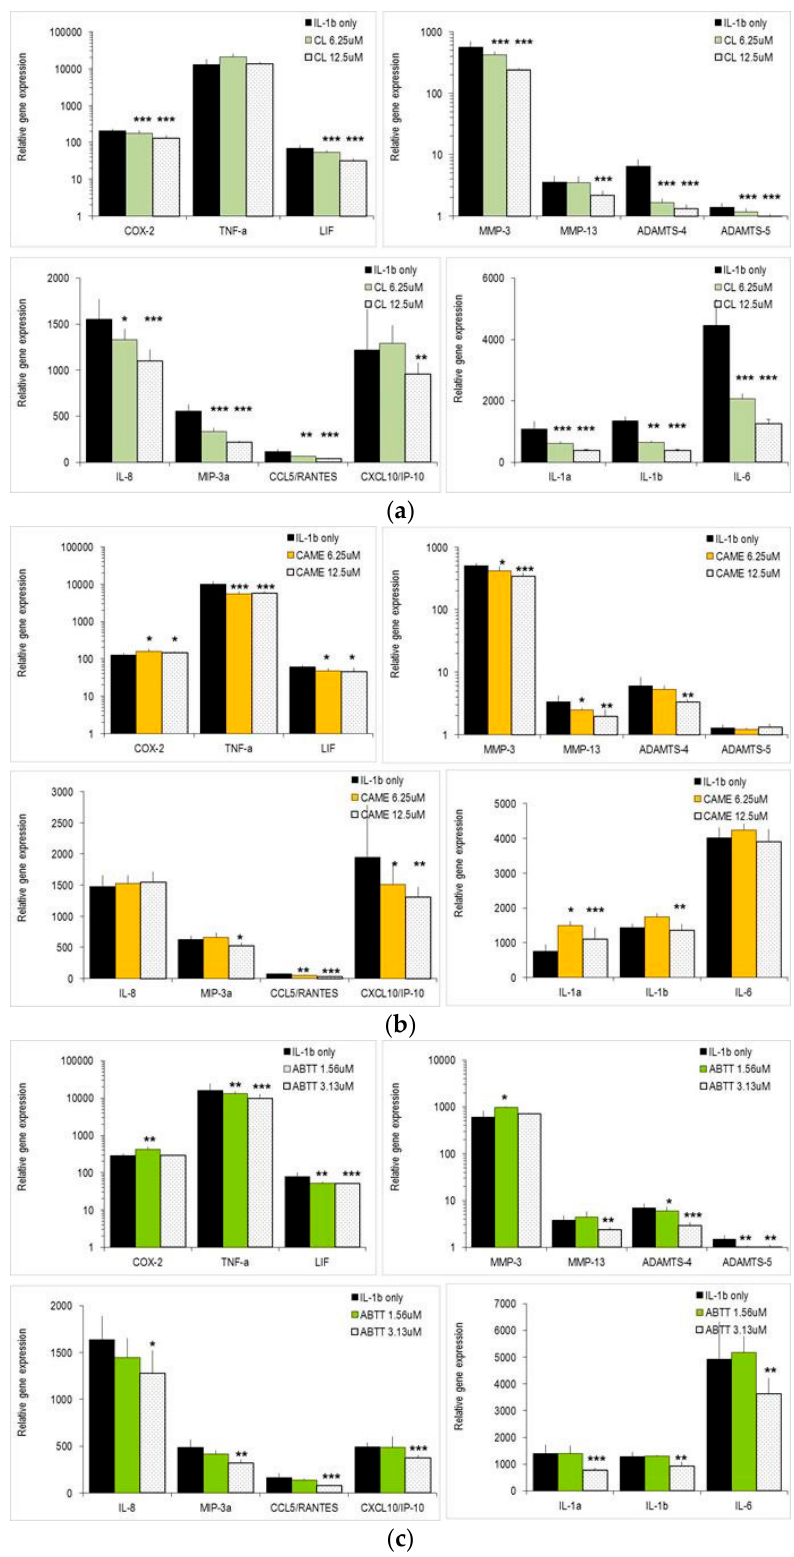
Figure 4. Effect of substances on IL-1 β activated NHAC-kn. Cells were stimulated with IL-1 β for 4 h in the presence of indicated substances. Gene expression was determined by quantitative RT-PCR as described in Figure 2. Asterisks indicate statistical significant differences compared to IL-1 β stimulated cells (* p < 0.05, ** p < 0.01, *** p < 0.001; n = 4). ( a ): Effect of carnosol (CL); ( b ): effect of carnosic acid 12-methylether (CAME); ( c ): effect of abieta-8,11,13-triene-11,12,20 triol (ABTT). Note log scale on the y axis in some panels.